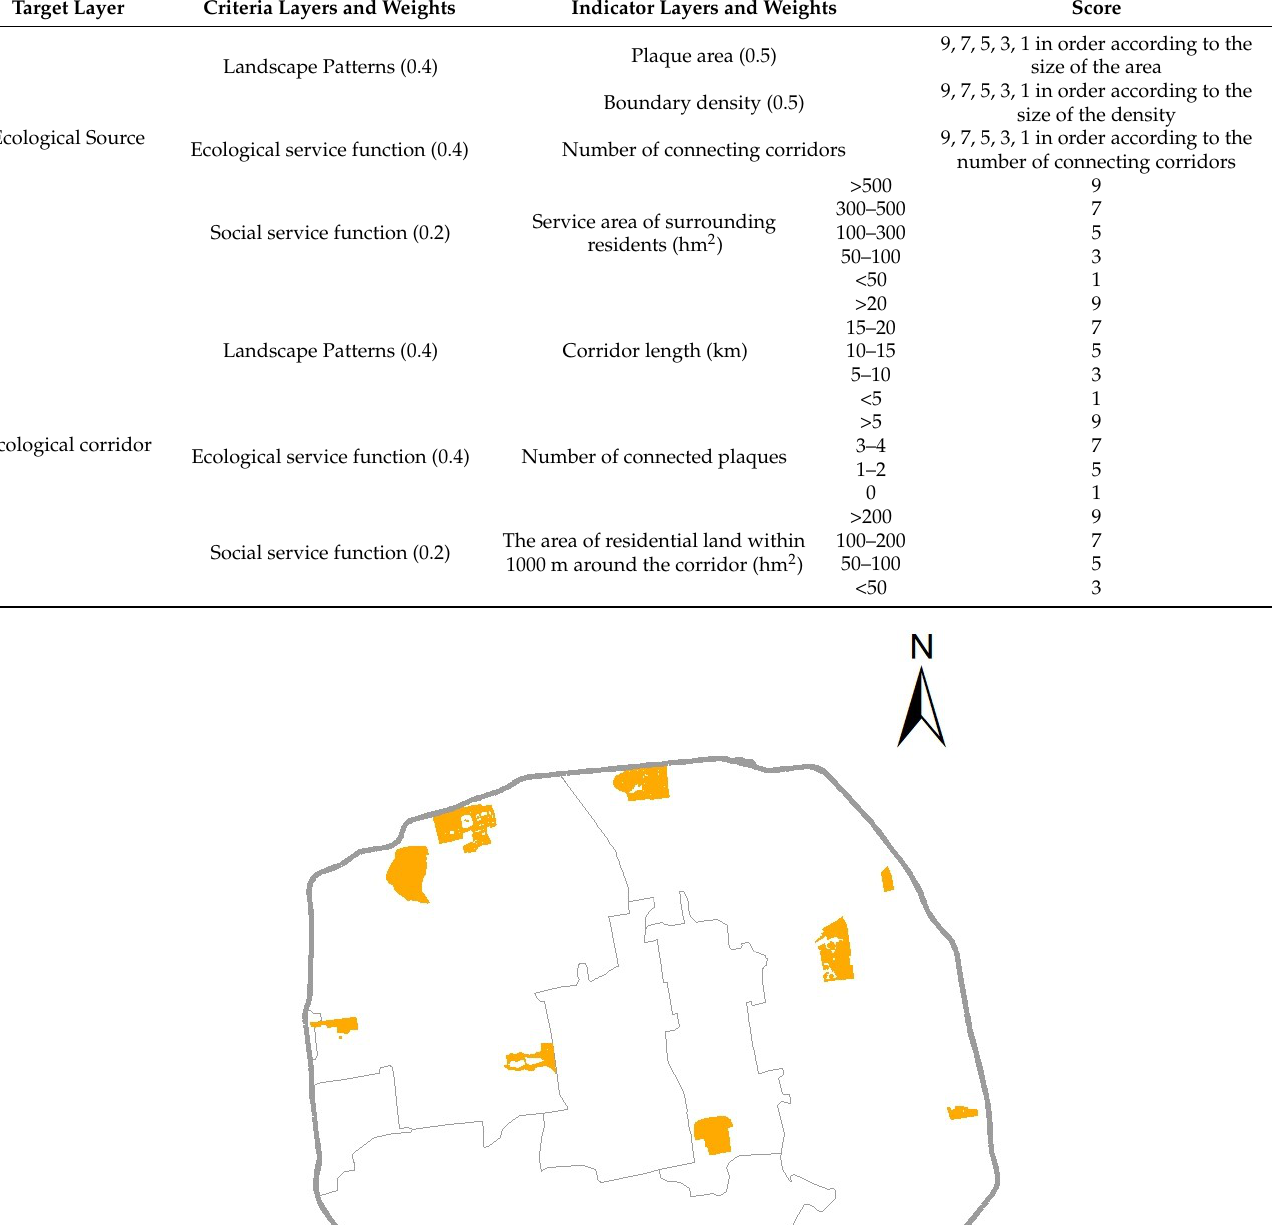
Table 5. Ecological network importance evaluation index.